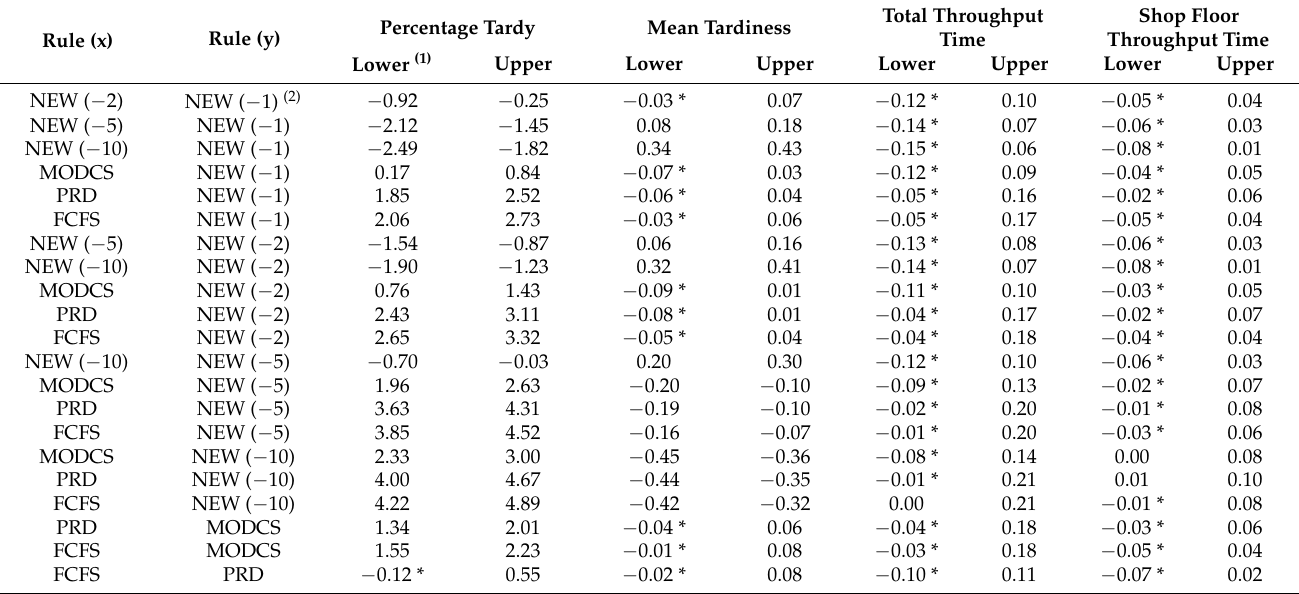
Table 3. Results for Scheff é multiple comparison procedure.